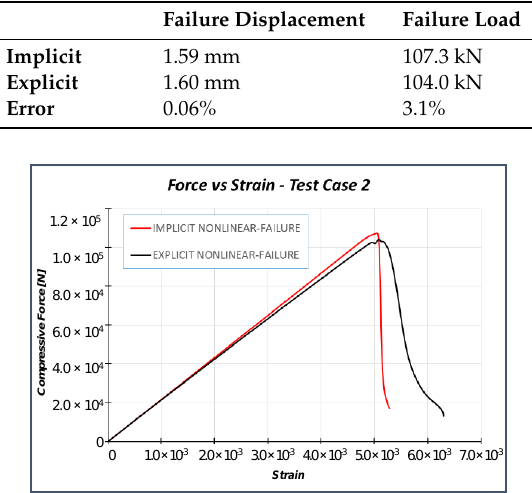
Table 4. Implicit–explicit formulation comparisons: Failure displacement and failure load.